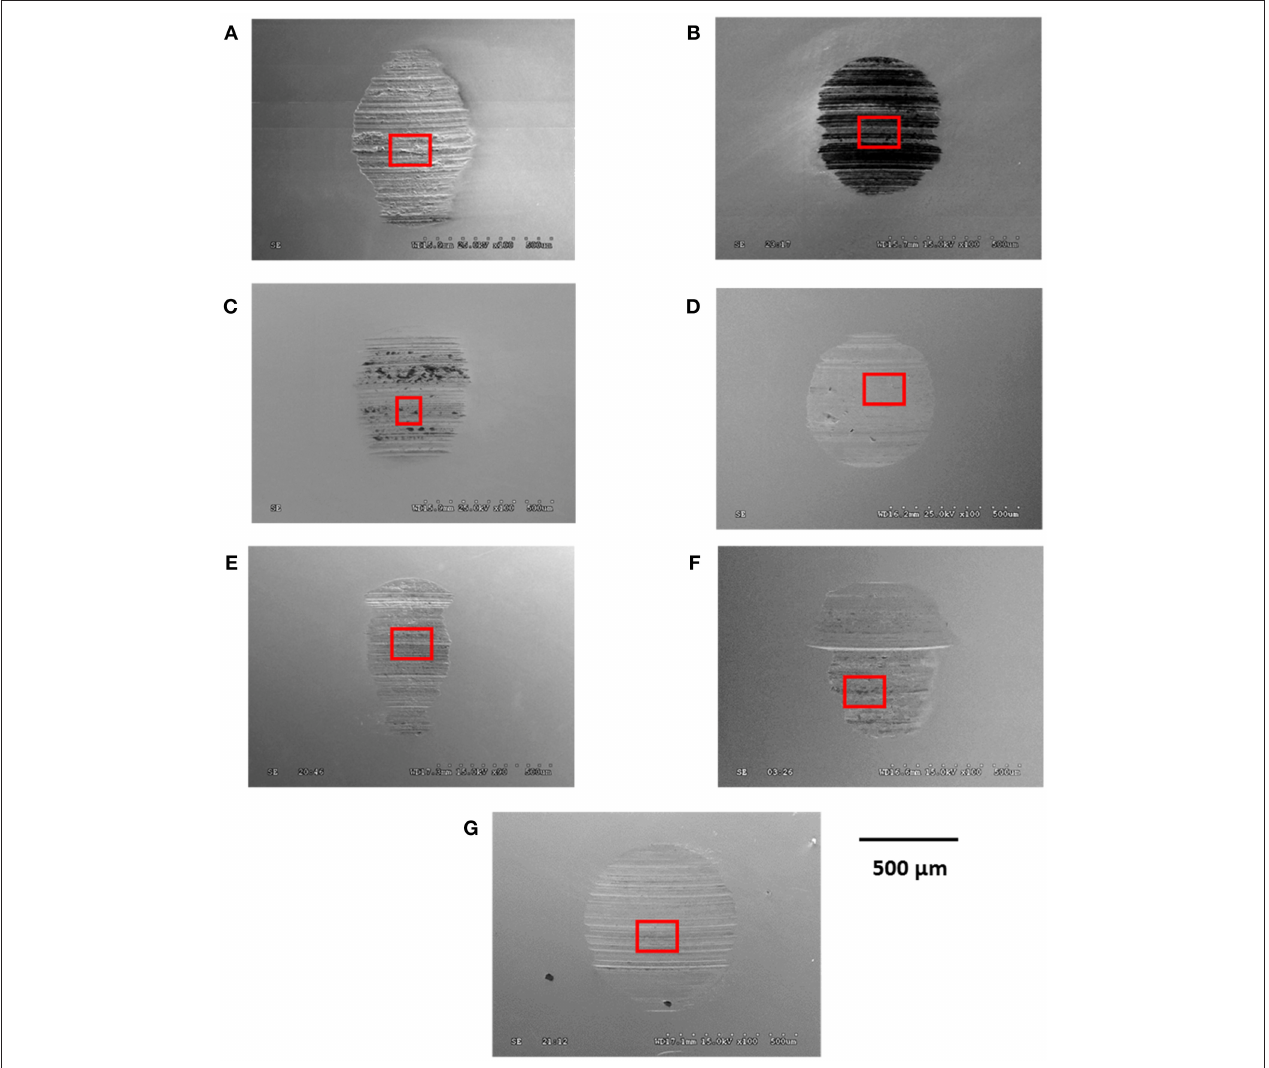
FIGURE 3 | Secondary electron microscopy images at 100X magnification of the wear scars from four ball wear tests for grease blends. (A) Base grease (B) MWCNT (C) P IL1 (D) P IL2 (E) N IL1 (F) N IL2 (G) ZDDP.